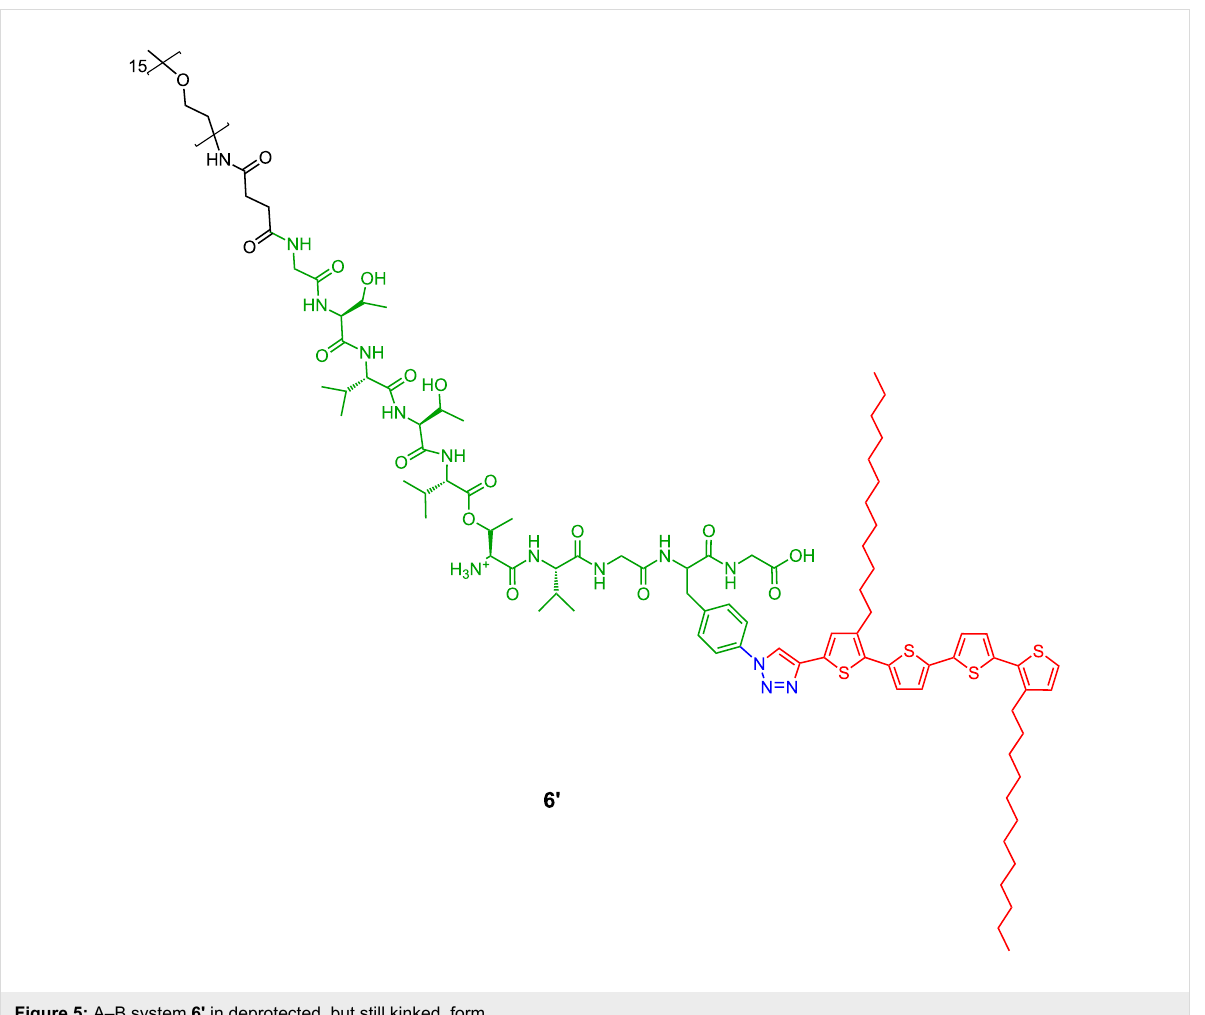
Figure 5: A–B system 6' in deprotected, but still kinked, form.